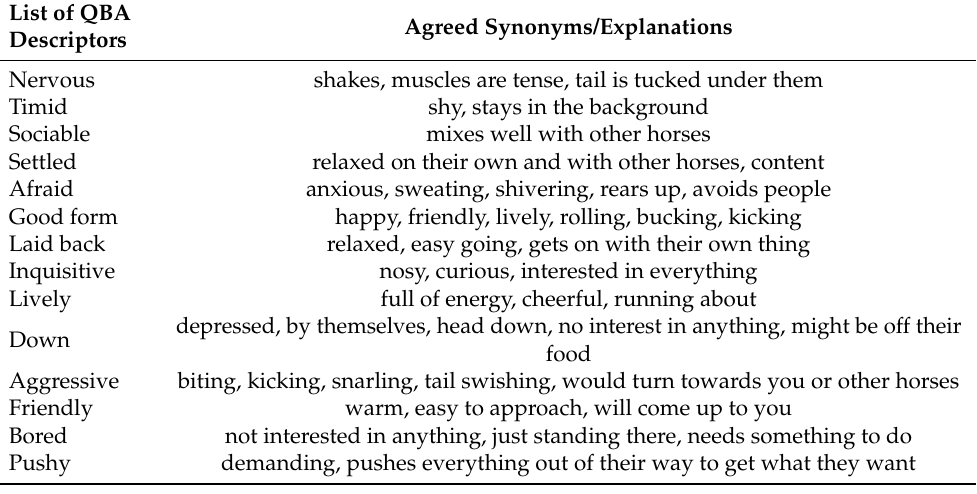
Table 1. List of QBA descriptors and agreed synonyms and explanations from the Traveller focus group.